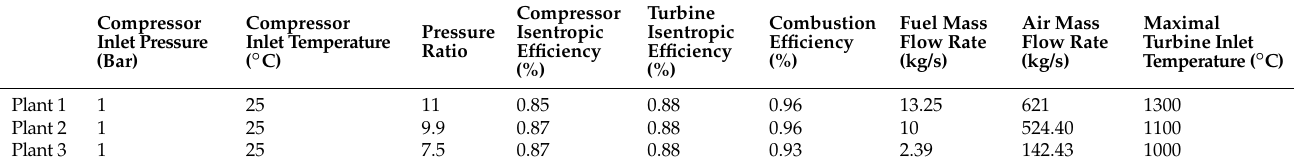
Table 3. Proprieties of ASC.